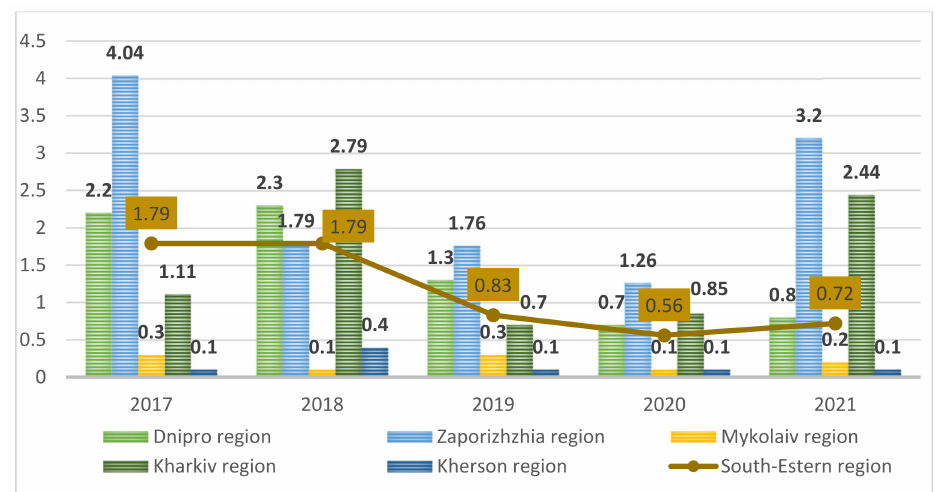
Figure 8. Index of environmental efficiency of investment in EGSAC in the context of the south- eastern region, 2017–2021 (constructed by the authors according to the data